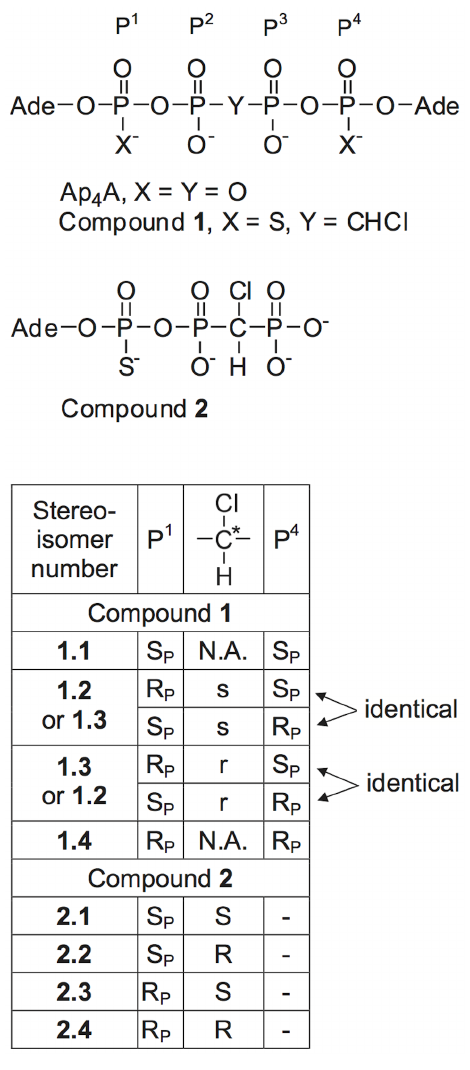
Figure 1. Chemical structure and stereo-configuration of the stereoisomers of diadenosine 5 9 ,5 00 -P 1 ,P 4 -dithio-P 2 ,P 3 -chloro- methylenetetraphosphate (compound 1), and of adenosine 5 9 - (P 1 -thio-P 2 ,P 3 -chloromethylenetriphosphate), (compound 2). R P and S P designate the absolute configuration of chiral P 1 - and P 4 - phosphorothioates; r and s, the absolute configuration of the pseudo- asymmetric carbon of the P 2 ,P 3 -chloromethylene group in compound 1 ; R and S, the absolute configuration of the chloromethylene group in compound 2 . Ade, 5 9 -adenosyl; N.A., Not Asymmetric.